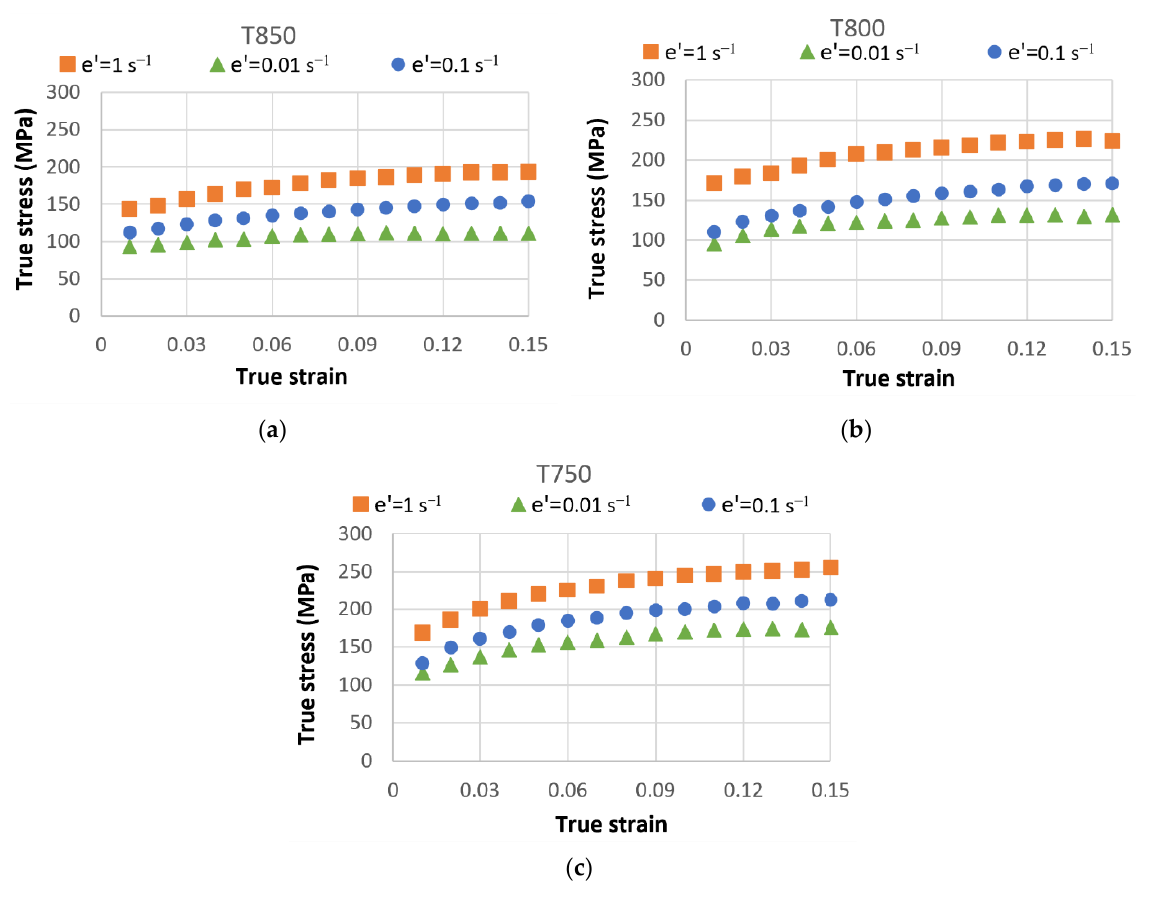
Figure 10. True stress – strain curves of USIBOR ® 1500 steel under different test temperatures (850°C, 800°C, 750°C) for different strain rates: ( a ) 1 s −1 , ( b ) 0.1 s −1 , ( c ) 0.01 s −1 .